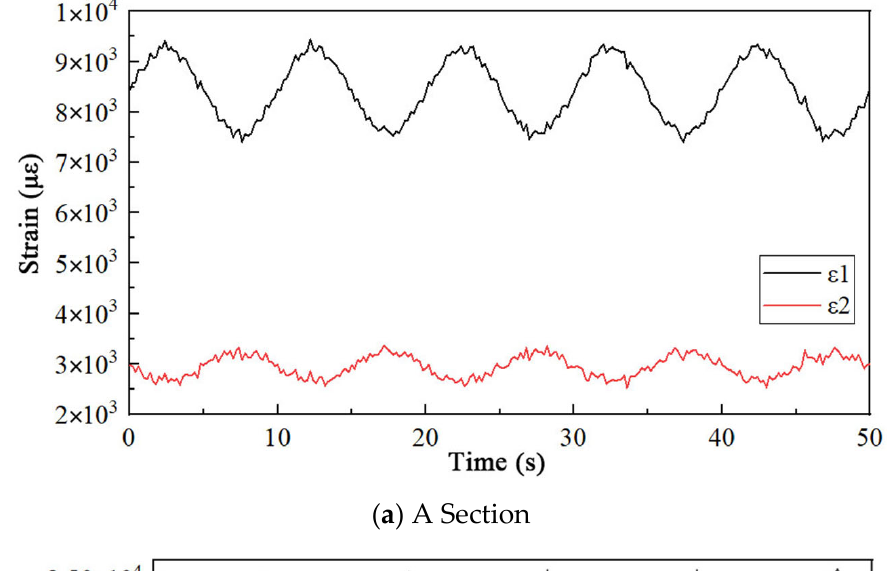
Table 7. Parameters When Simulating the Motion of the Deck under Each Sea State.